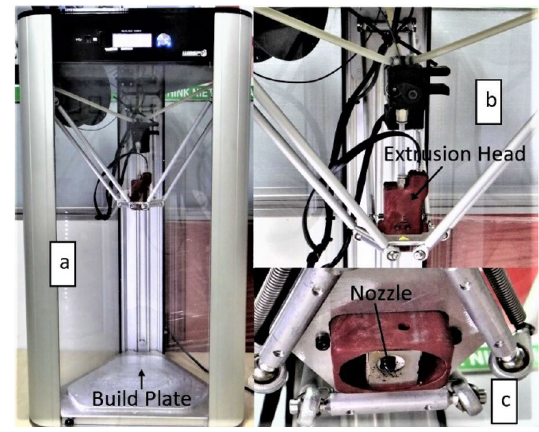
Figure 2 a 3D printer, b close up view of extrusion head, c close-up view of the